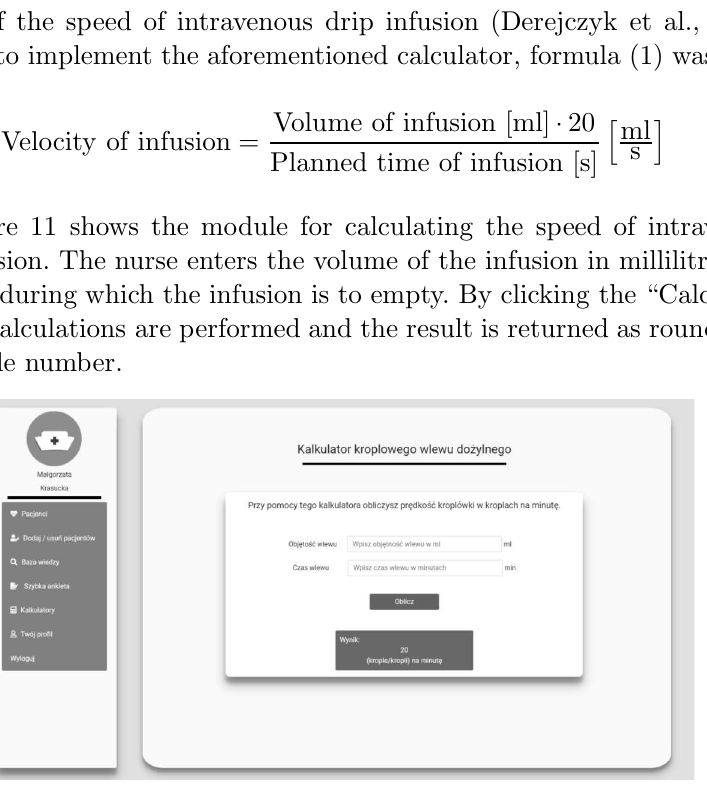
Figure 11. Module for calculating the speed of intravenous drip infusion